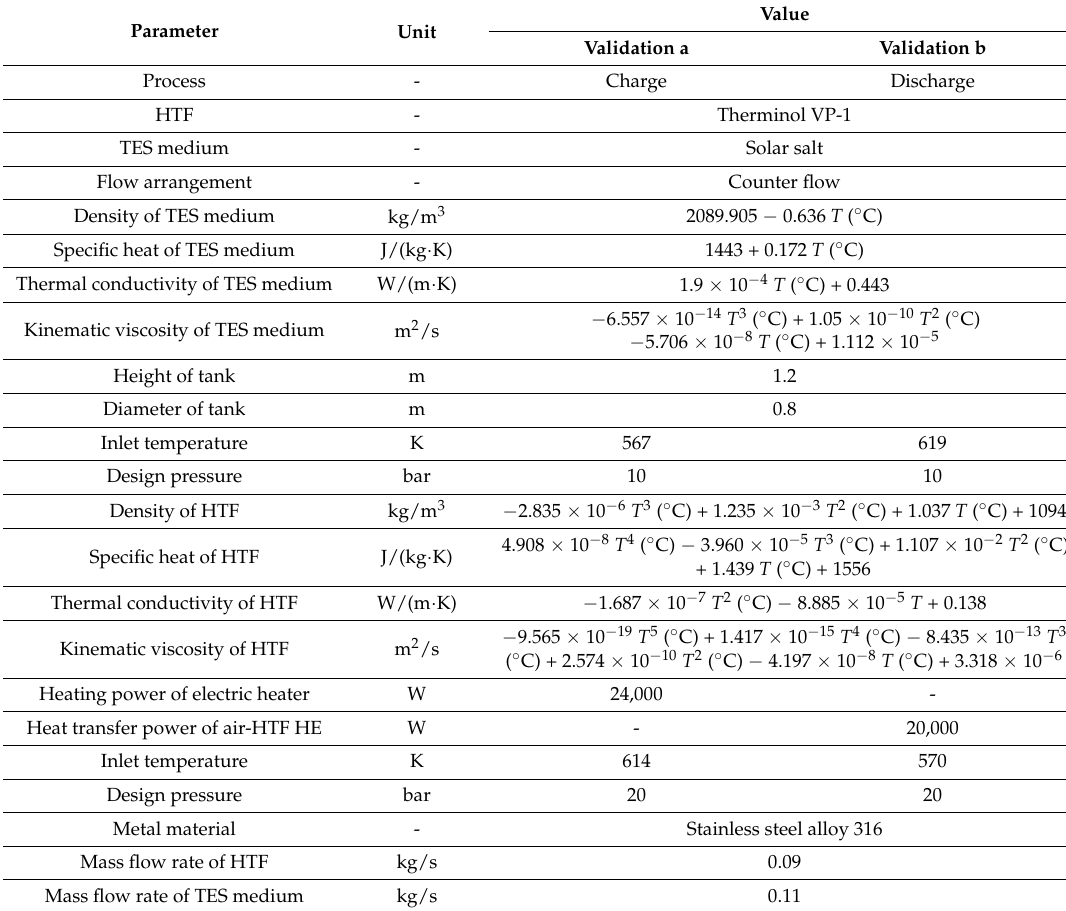
Table 2. Experimental conditions for model validation.